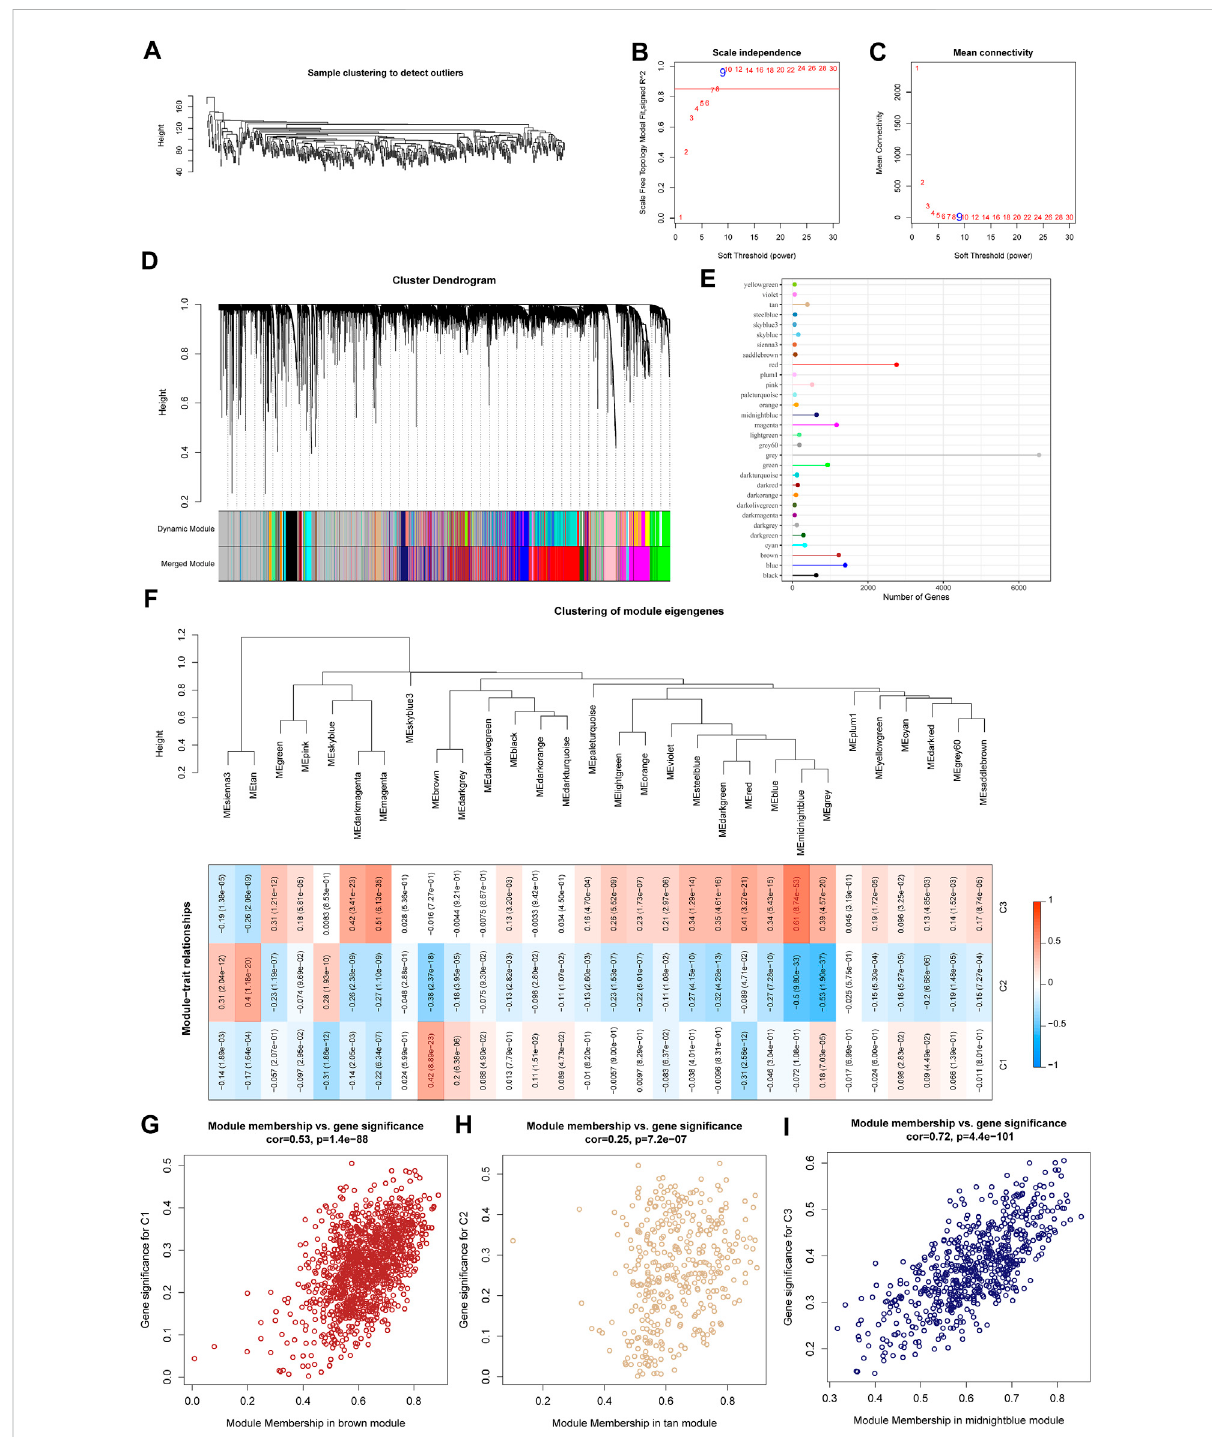
FIGURE 4 WGCNA analysis identi fi es molecular subtype-associated gene modules. (A) Clustering tree of each sample; (B) Analysis of the scale-free fi t index for various soft-thresholding powers ( β ). (C) Analysis of the mean connectivity for various soft-thresholding powers. (D) Dendrogram of all differentially expressed genes/lncRNAs clustered based on a dissimilarity measure (1-TOM); (E) statistics of the number of genes in each module; (F) correlation between the module eigenvectors of each module and clinical information; (G) Scatter diagram for module membership vs. gene signi fi cance for C1 in the brown module; (H) Scatter diagram for module membership vs. gene signi fi cance for C2 in the tan module; (I) Scatter diagram for module membership vs. gene signi fi cance for C3 in the middlenightblue